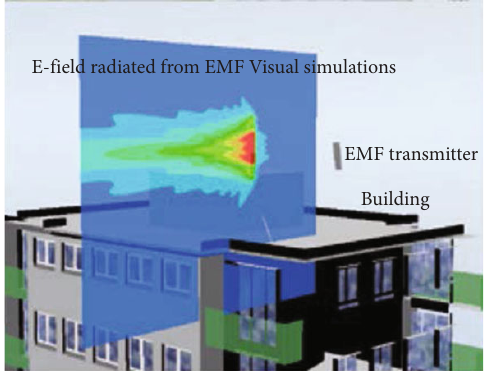
Figure 2: 3D E- fi eld radiated in front of the BTS antenna from EMF visual simulations